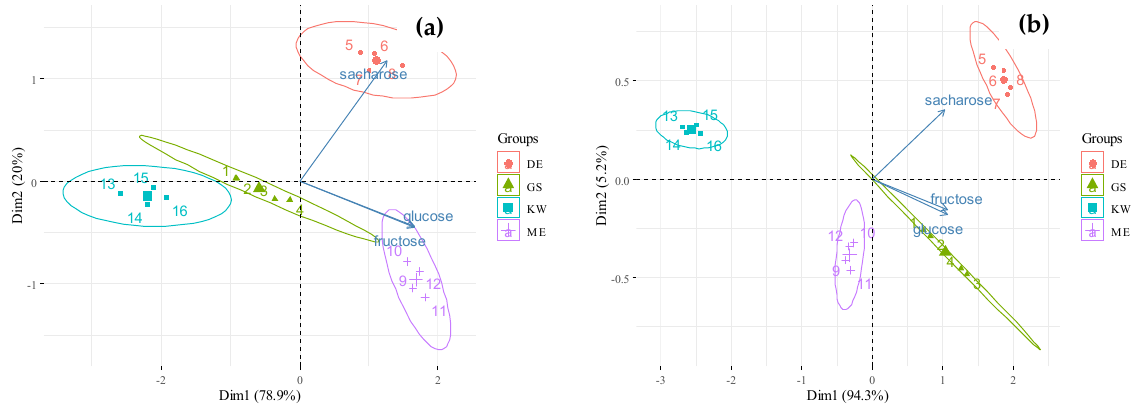
Figure 8. Sugar concentration ( a ) and sugar yield ( b ).